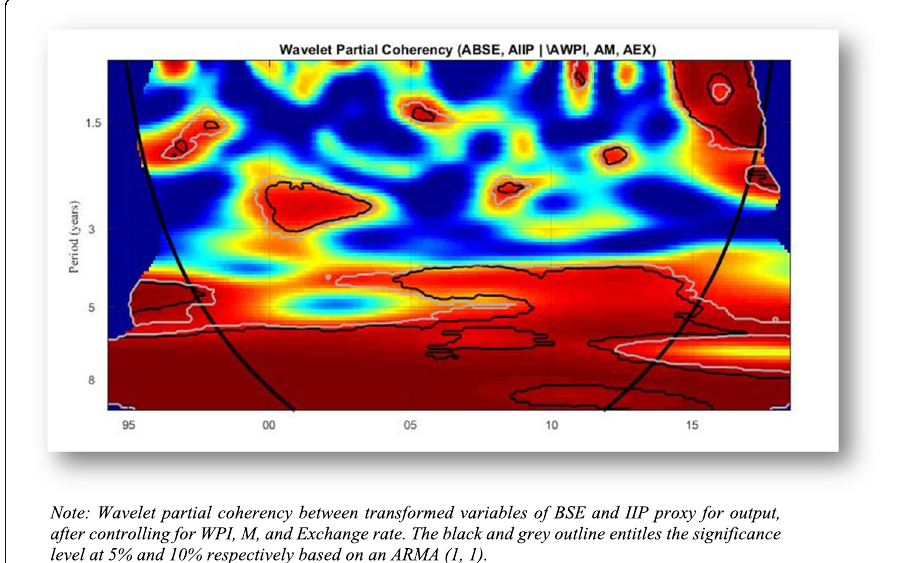
Fig. 8 Wavelet Partial Coherency for Transformed